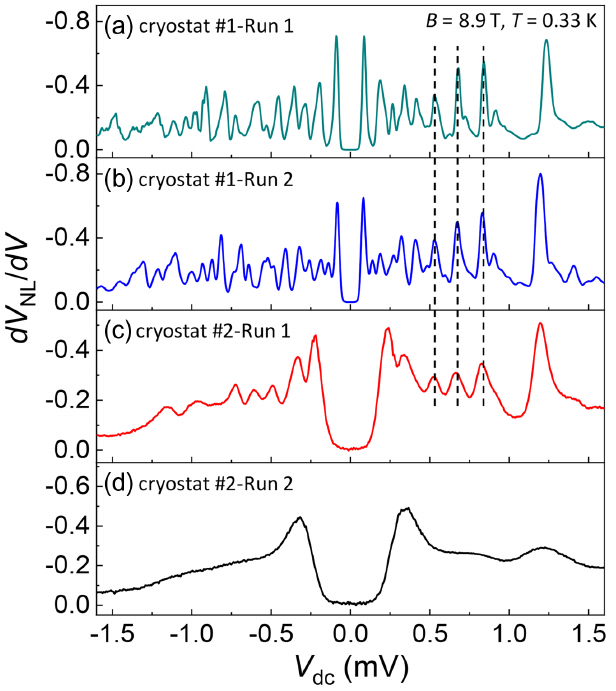
FIG. 13. Sensitivity of Fabry-P´erot resonance to rf noise. (a) and (b) are from a He3 cryostat equipped with rf filtering using thermocoax cables (THERMOCOAX, Inc. Model 1 Nc Ac 05, length > 2 m ). The sample is thermal cycled to above 20 K in =dV reproduce very between (a) and (b). Resonant peaks in dV NL well, apart from an occasional small shift. (c) and (d) are obtained at the MagLab using the dilution fridge of the 18 T system (SCM1). They reproduce the envelope of the nonlocal signal but exhibit larger onset dc bias and substantially fewer resonance peaks. Environmental noise that leads to decoherence is likely the cause. The severity of the problem also depends on what other instruments are running at the same time. The situation in (d) is worse than in (c). From device 606. T ¼ 0 . 33 K. B ¼ 8 . 9 T. Data presented in Fig. 5(a) are obtained in the run of (c), where we track the magnetic field dependence of the three strong resonance peaks that reproduce well to 18